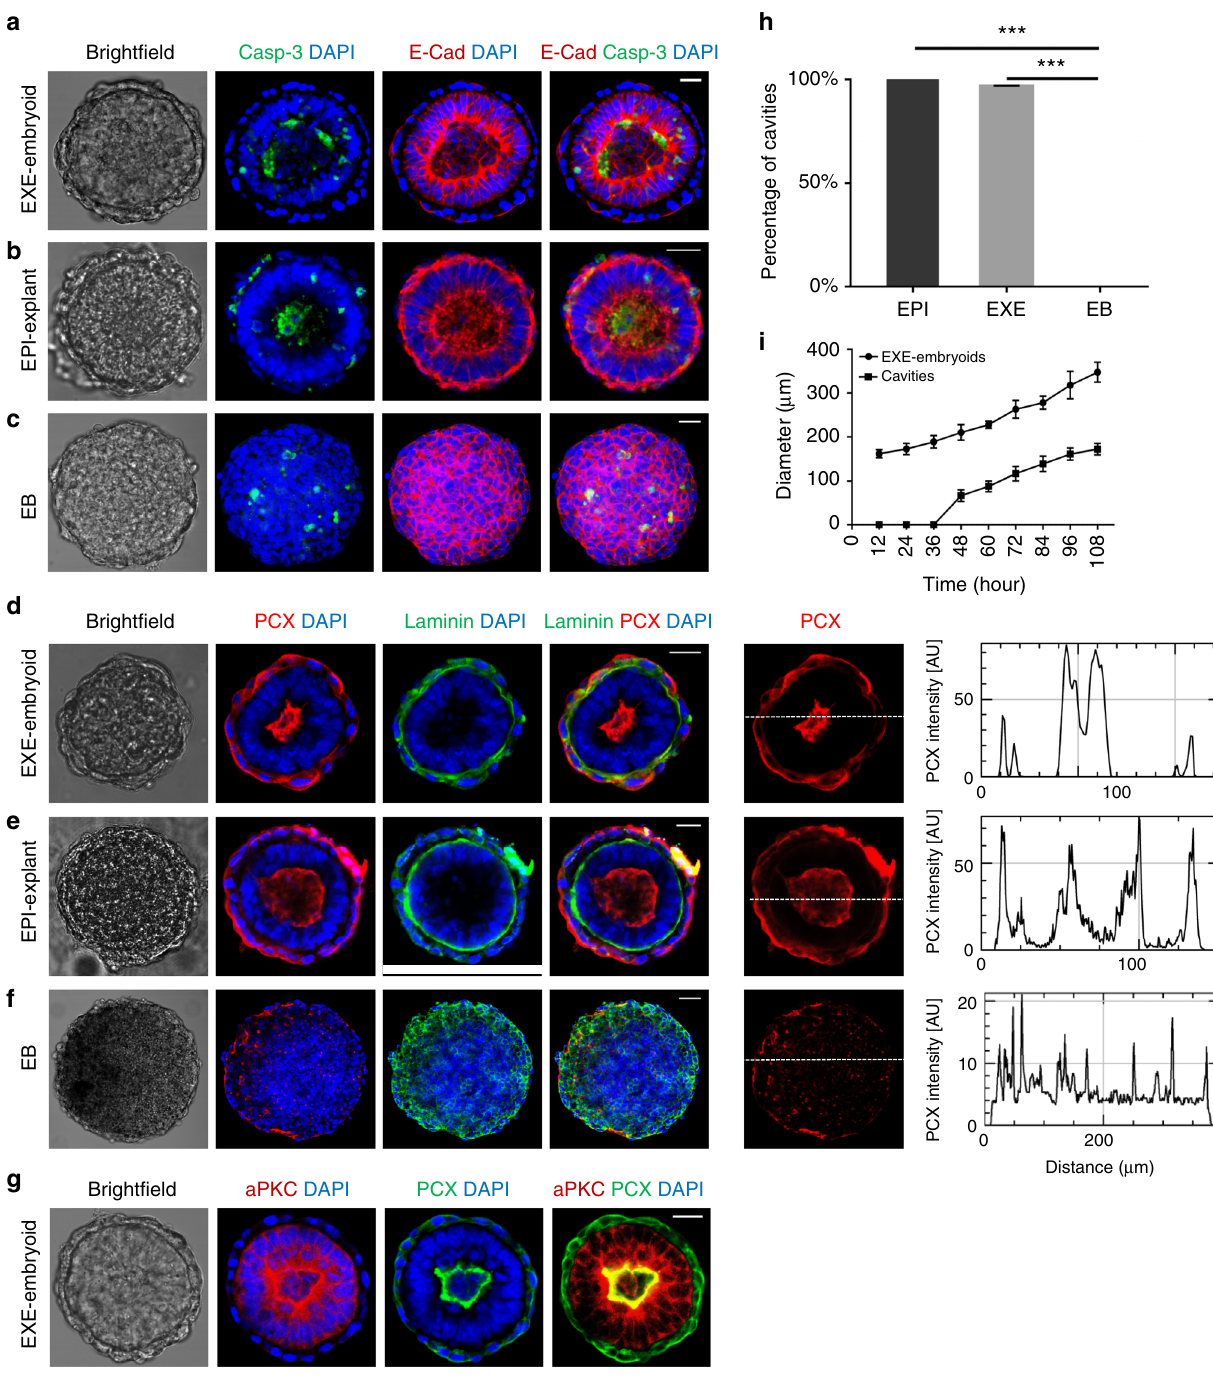
Fig. 2 Lumenogenesis in EXE-embryoids. a EXE-embryoids stained to reveal cleaved caspase-3, green; E-Cadherin, red; and DAPI, blue. n = 20 EXE- embryoids. b EPI-explants stained to reveal cleaved caspase-3, green; E-Cadherin, red; and DAPI, blue. n = 10 EPI-explants. c EBs stained to reveal cleaved caspase-3, green; E-Cadherin, red; and DAPI, blue. n = 30 EBs. d EXE-embryoid shows the cavity and Laminin niche via immunostaining: PCX, red; Laminin, green; and DAPI, blue. n = 30 EXE-embryoids. The right-most panel shows the intensity scan of PCX along a white line drawn at the middle z-plane of the EXE-embryoid; the presence of the cavity is indicated by two strong peaks in the intensity pro fi le. e EPI-explants show the cavity and laminin niche via immunostaining: PCX, red; Laminin, green; and DAPI, blue. n = 30 EPI-explants. The right-most panel shows the intensity scan of PCX along a white line drawn at the middle z-plane of the EPI-explants, indicating cavity formation. f EBs cannot form a cavity or Laminin niche: PCX, red; Laminin, green; and DAPI, blue. n = 30 EBs. The right-most panel shows the intensity scan of PCX along a white line drawn at the middle z-plane of the EBs, indicating no cavity formation. g Localization of PCX and aPKC in EXE-embryoids show cavity, aPKC marked apical side of cells. PCX, green; aPKC, red; and DAPI, blue. n = 20 EXE-embryoids. h Percentage of cavity formation in EXE-embryoids, EPI-explants, and EBs. Two-tailed Student ’ s t -test; means± s.e.m. Three experiments. *** P < 0.001. i The mean external diameters of the EXE-embryoids and the mean internal diameters of the cavities in the EXE-embryoids enlarged along with time of in vitro culture. n = 20 EXE-embryoids at each time points. Means ± s.d. Scale bar, 20 µ m ( a – e , g ), 50 µ m ( f ). Experiments were repeated at least three times with similar results ( a – g ). Source data of h and i are provided as the Source Data fi